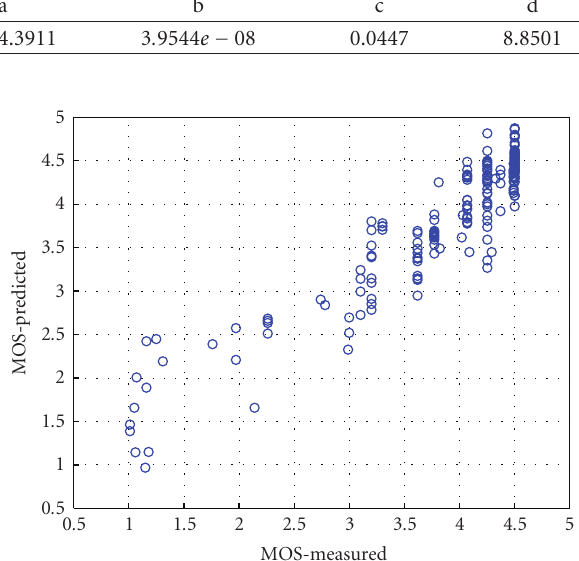
Figure 18: Predicted versus measured MOS results (ANFIS-based).